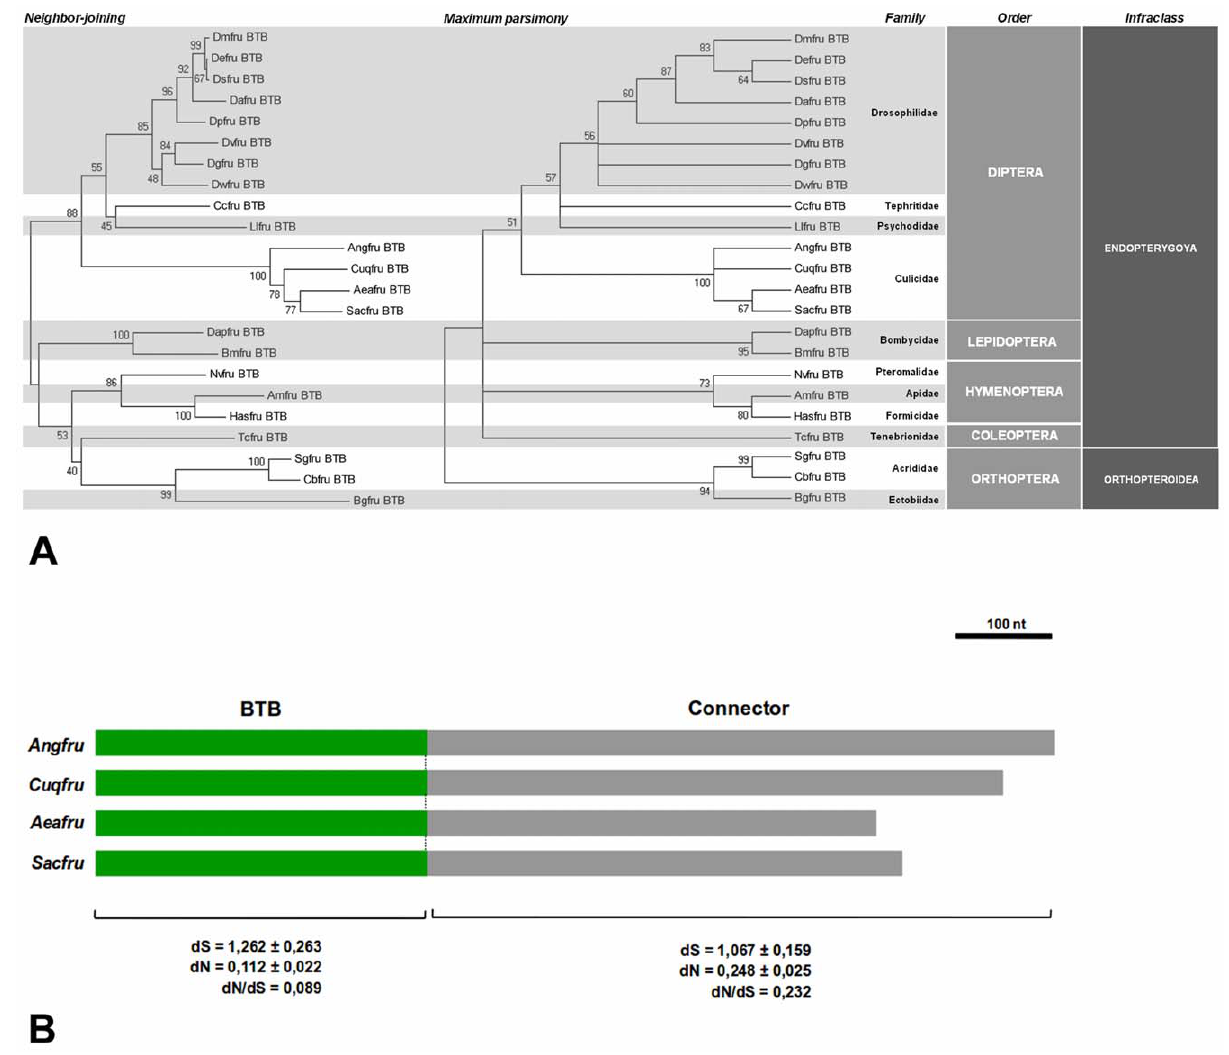
Figure 4. Phylogenetic and molecular evolution analyses. (A) NJ and MP consensus trees based on nucleotide alignment of the BTB encoding region of the fru gene of different insect species. (B) Diagram showing the BTB and the connector domain of the fru gene in four mosquito species. The dN, dS and dN/dS ( v ) values for each domain are reported below the scheme.